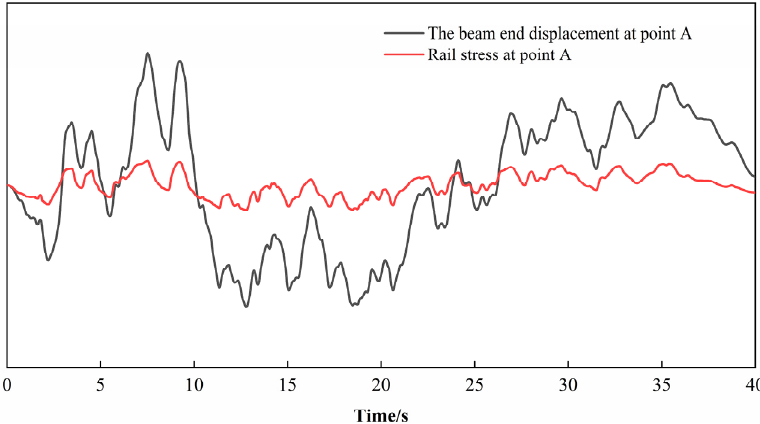
Figure 21. Comparison of stress–time-history curve at point A and displacement time history curve at point A. Table 9. Numerical value of PPMCC of displacement and stress at point